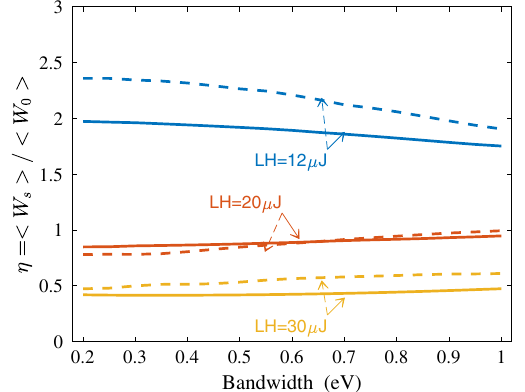
FIG. 16. Comparisons of the ratios of the μ BI-induced side- bands and SASE background versus integration bandwidth under different LH settings at U15. The ratios are calculated by the deduction of measured spectra (solid line) and the number of modes in statistical analysis (dashed line). The integration bandwidth is again offset − 1 . 4 eV from the seed